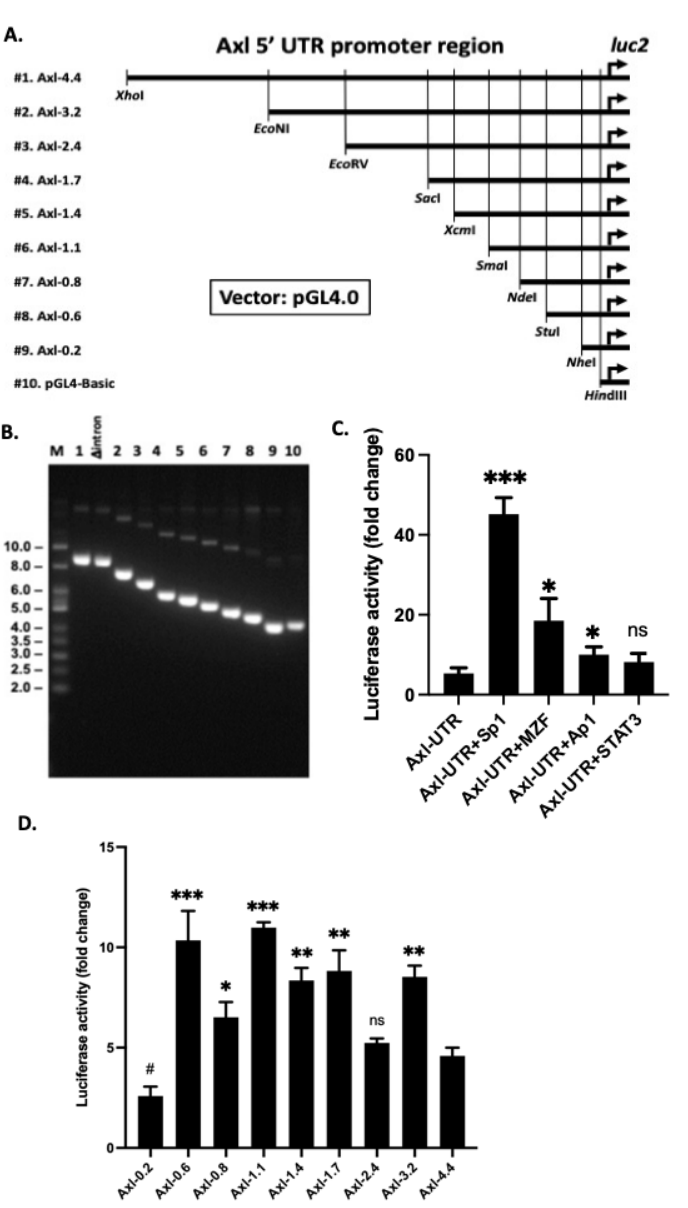
Figure 2. Axl promoter region constructs and luciferase assay. ( A ) schematic representation of serial deletion constructs of the Axl promoter region; ( B ) gel electrophoretic analysis of the Axl promoter serial deletion constructs. HeLa cells were transient transfected with various pGL4-Axl-luc2 reporters, with ( C ) or without ( D ) transcription factor expression vectors. Luciferase activity was assayed 24 h after DNA transfection. Experiments were repeated at least twice. Student t-test was performed to compare all constructs to the same full length Axl construct, Axl-UTR ( C ) or Axl-4.4 (Axl-UTR) ( D ). * p < 0.05, ** p < 0.01, *** p < 0.001, # p < 0.05, ns, not significant. The asterisk sign indicates significantly higher. The pound sign indicates significantly lower.